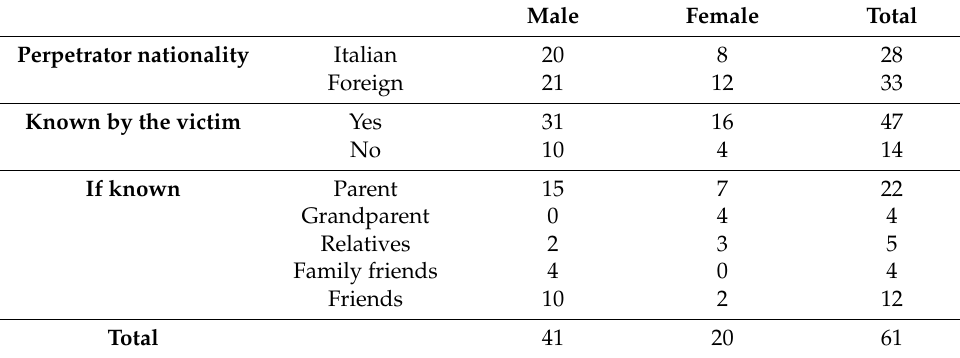
Table 2. Descriptive information about perpetrators, by